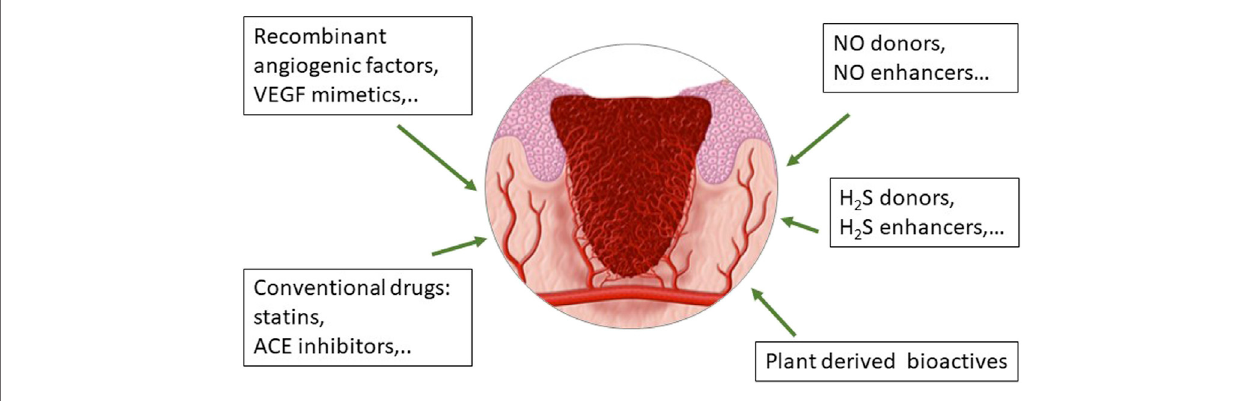
Frontiers in Bioengineering and Biotechnology |